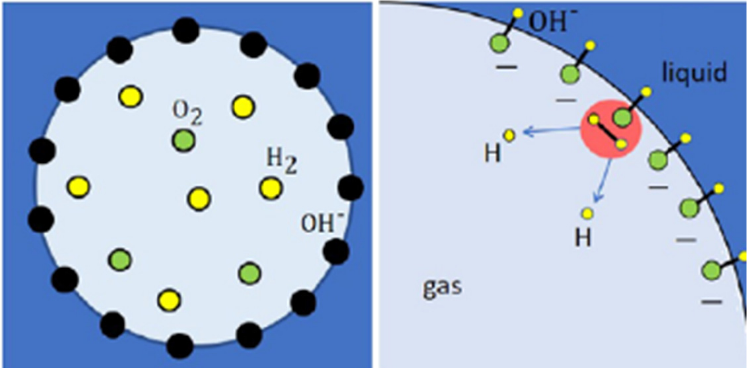
Figure 7. Schematic overview of chemical reaction happening on the bubble surface. Reprinted from [27]. Copyright (2022), with permission from Elsevier.